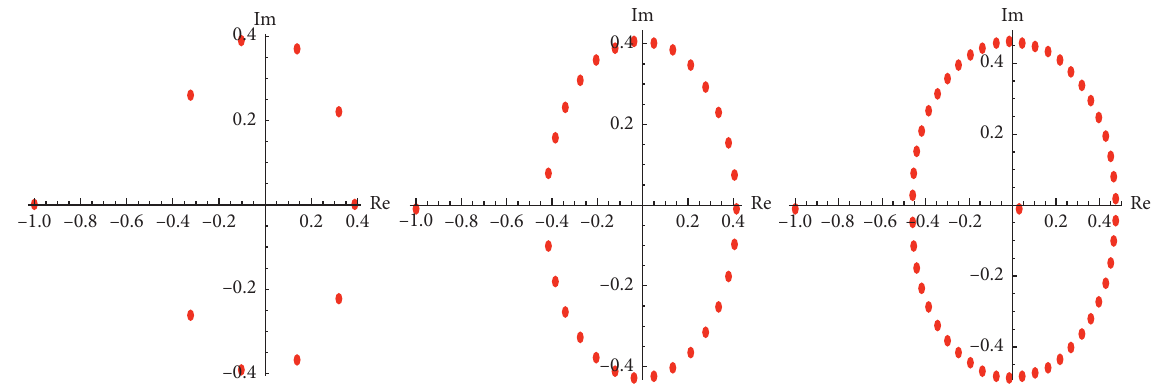
Figure 1: Zeros of S